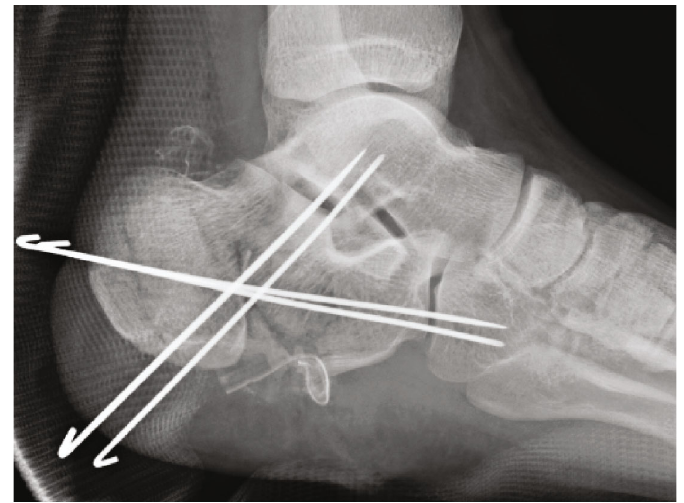
Figure 3: Irrigation, debridement, and pinning by four Kirschner wires were performed following the trauma resuscitation. The wound was closed.